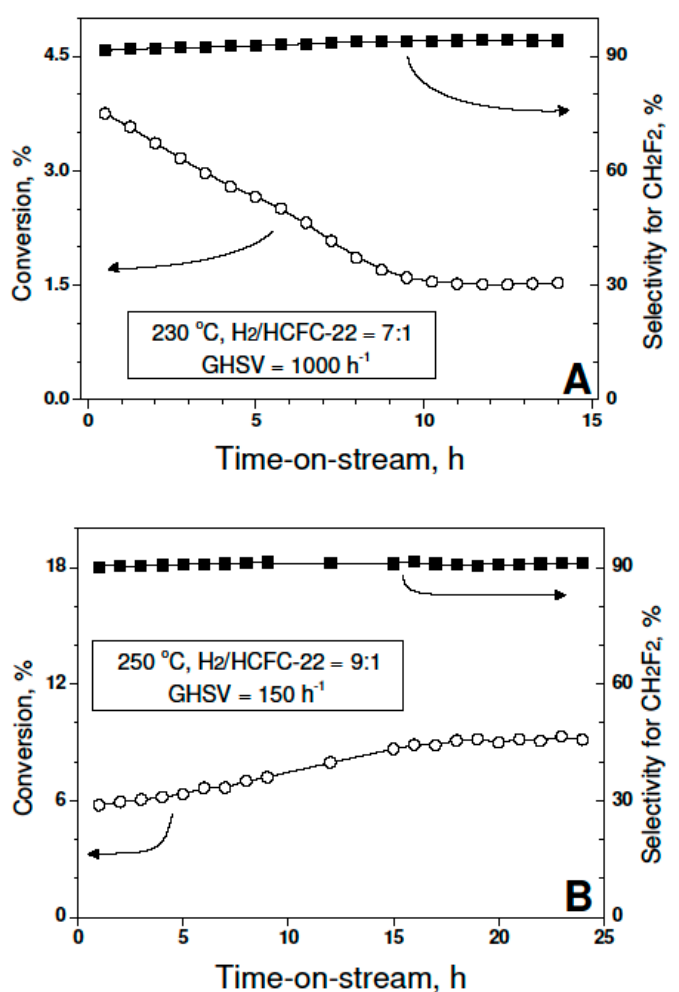
Figure 8. Time-on-stream behavior (conversion of CHClF 2 and selectivity to CH 2 F 2 ) of 3 wt % Pd/carbon at different reaction conditions incorporated in ( A , B ) sections. Norit RO 08 carbon support was heated in helium at 1800 ◦ C for 2 h. Reaction conditions (temperature, H 2 /HCFC-12 ratio and GHSV) are included in figure